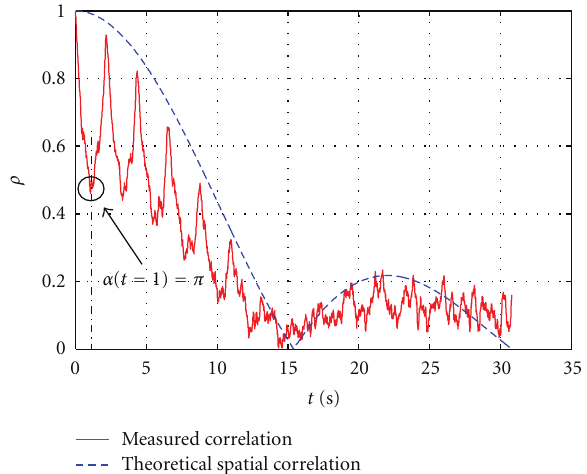
Figure 3: Measured signal correlation as a function of time.